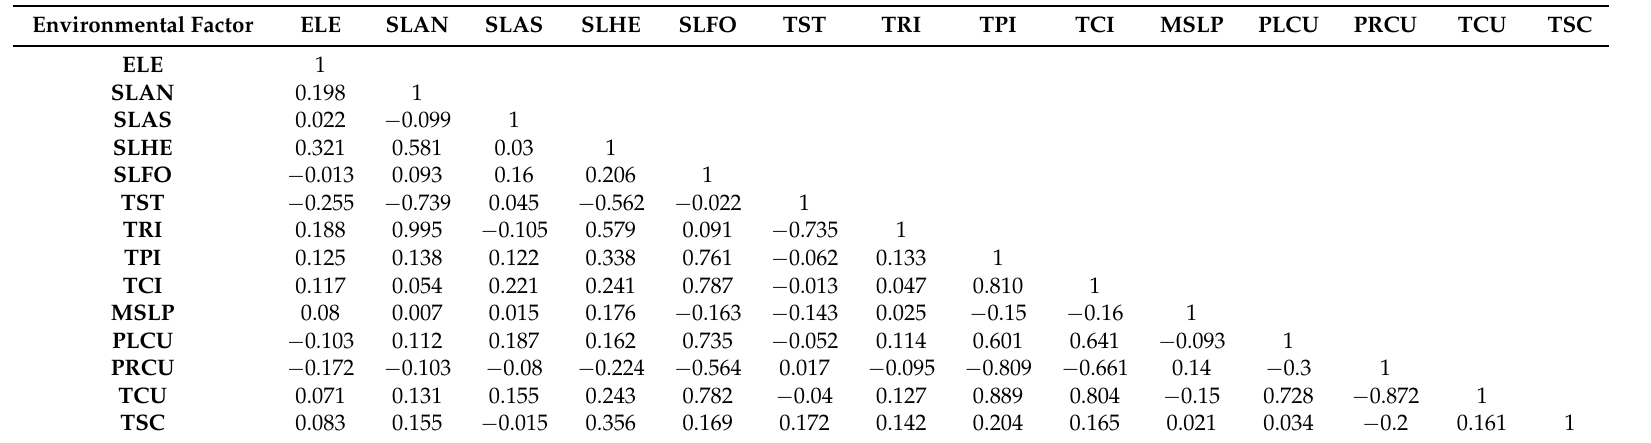
Table 5. Correlations of geomorphological factors.